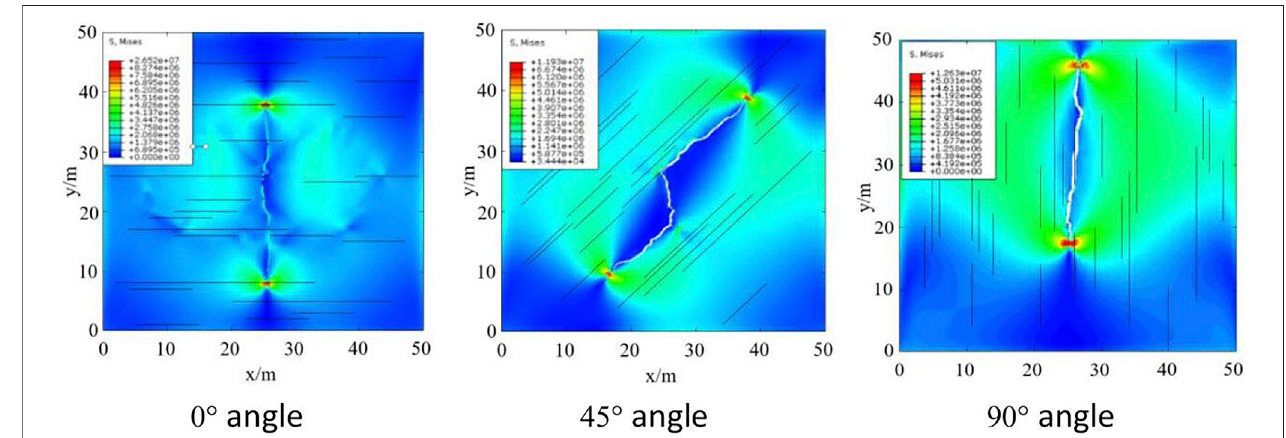
FIGURE 7 | Hydraulic fracture propagation pattern of different natural fracture angle. < /b > 0 ° angle.45 ° angle.90 °